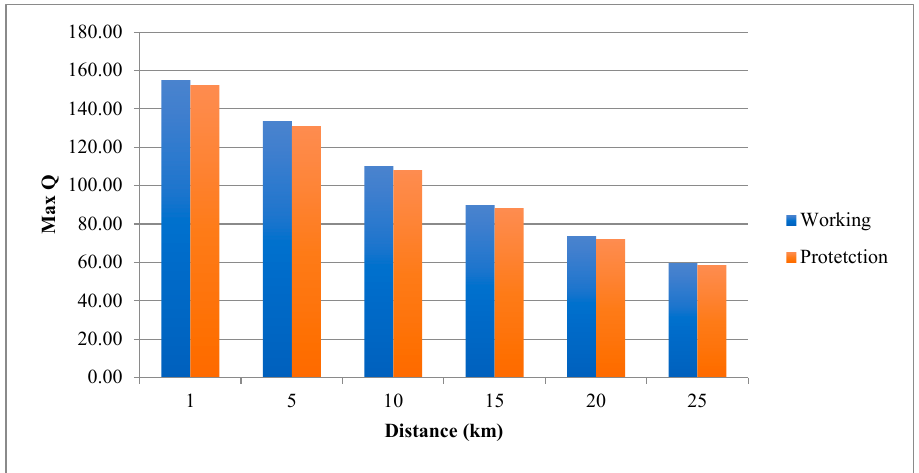
module installed in the FTTH network, the maximum Q recorded was considered high and within the reasonable value for the digital or optical communication requirement [21]. The maximum value obtained was in the 1 km distance where the working link recorded 155.10 and protection link was 152.25. Meanwhile for 20 km distance, the working link was 73.81 and protection link was 71.81, as shown in Figure 18.